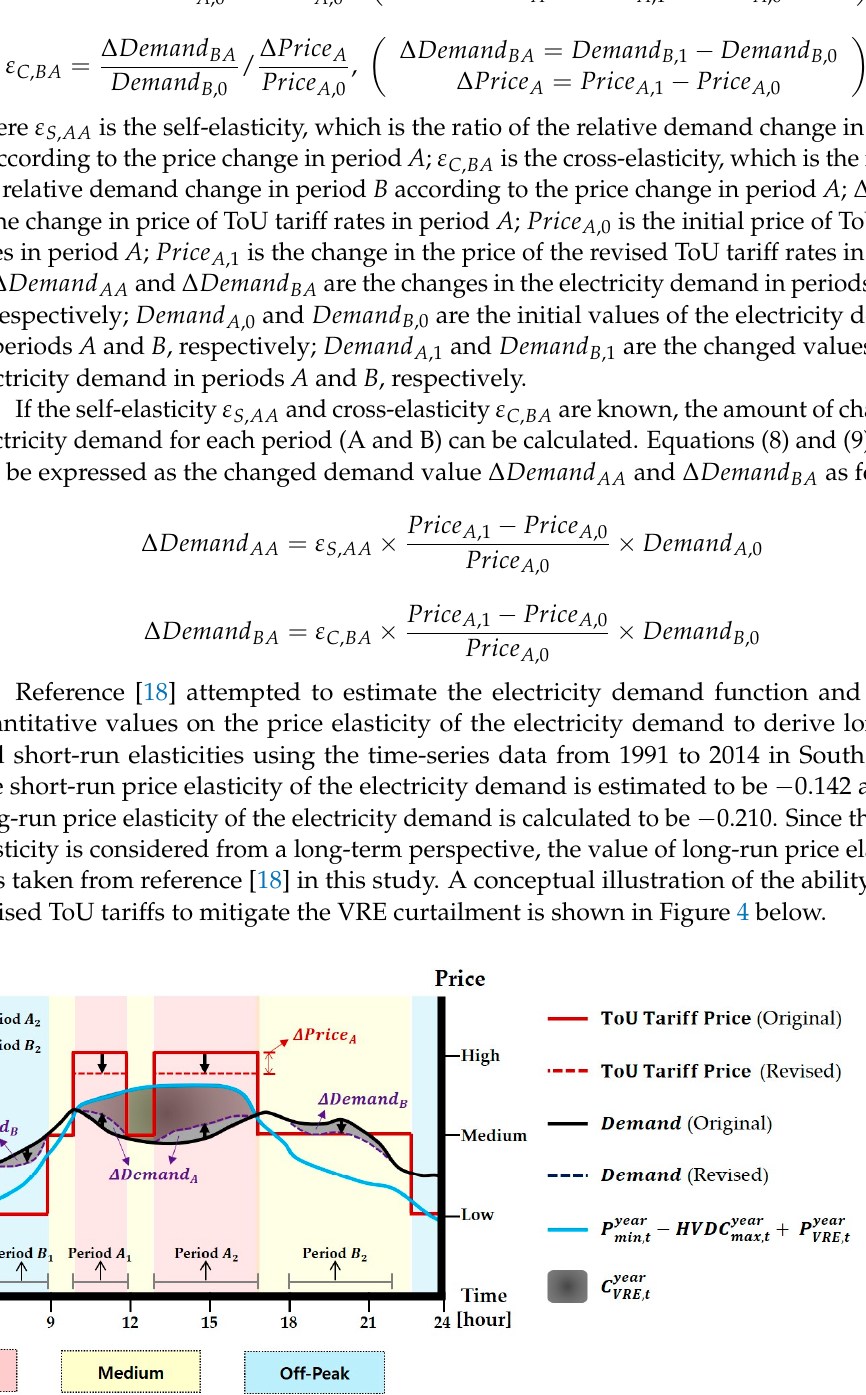
Figure 4. Conceptual illustration of the mitigation of the VRE curtailment by revised ToU tariffs.